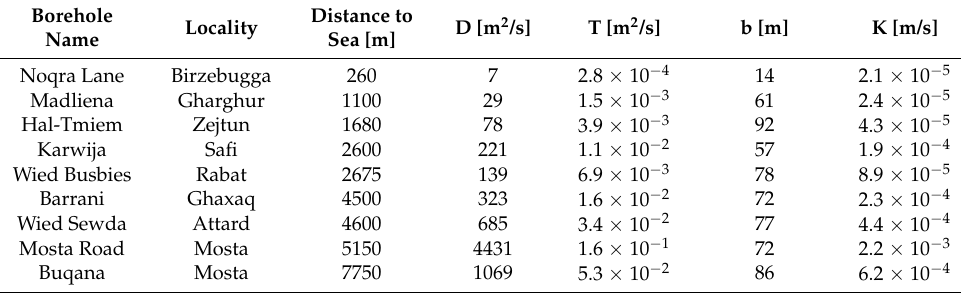
Table 2. Average values of analysed monitoring boreholes during the period of analysis (from 1st May until 31st July